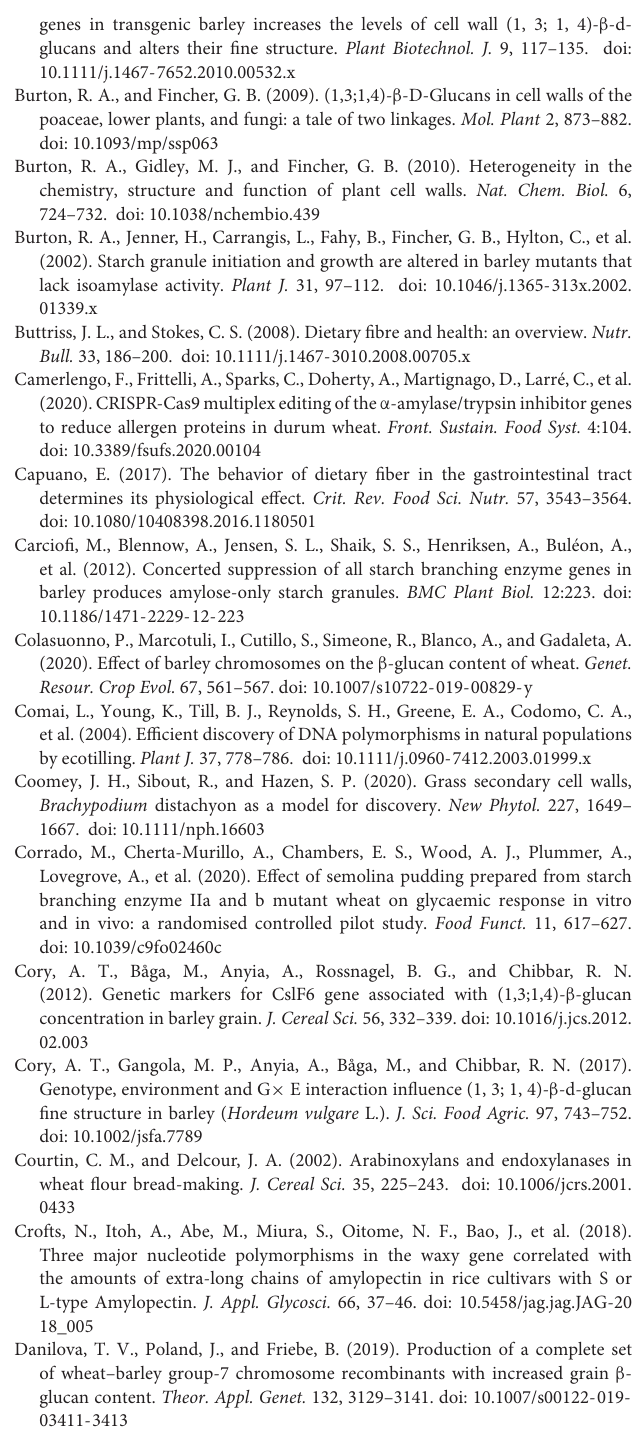
Supplementary Table 1 | Amount of DFs in different seed tissues of major cereals. Supplementary Table 2 | High Resistant starch genotypes in major